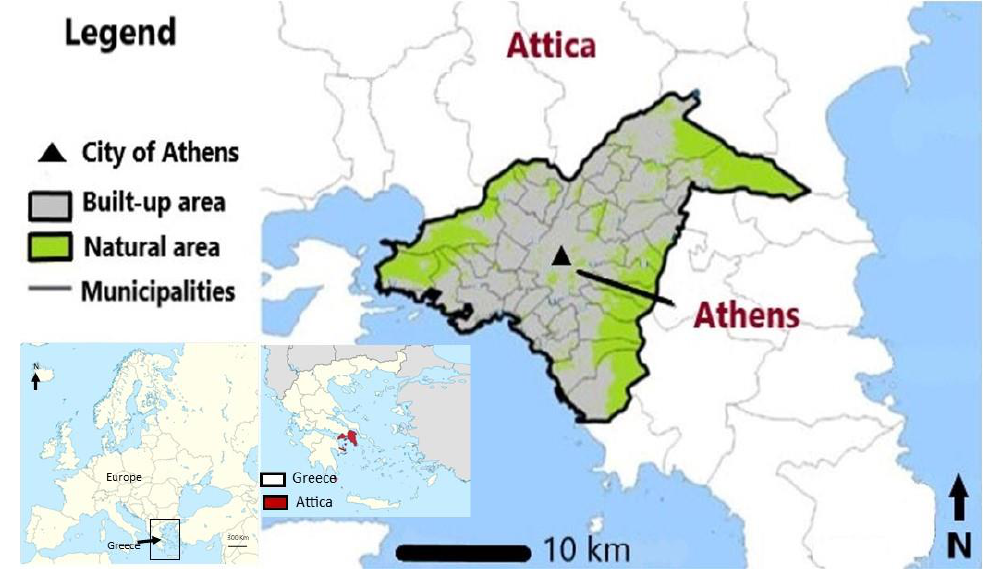
Figure 1. Map depicting the prefecture of Athens in Attica region. In inlets, the location of Greece in Europe and the location of Attica region in Greece